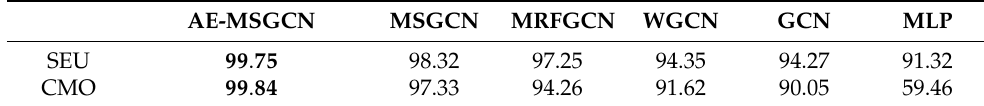
Table 6. Fault diagnosis accuracy (%) of different methods for the two